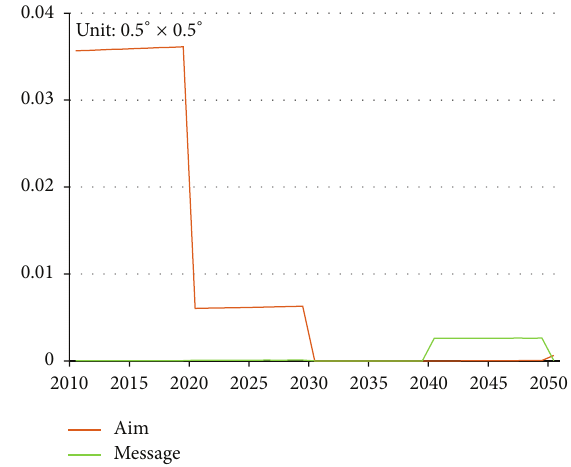
Figure 2: Conversion from grassland to forestland under the RCPs scenarios in Fujian province, 2010–2050.